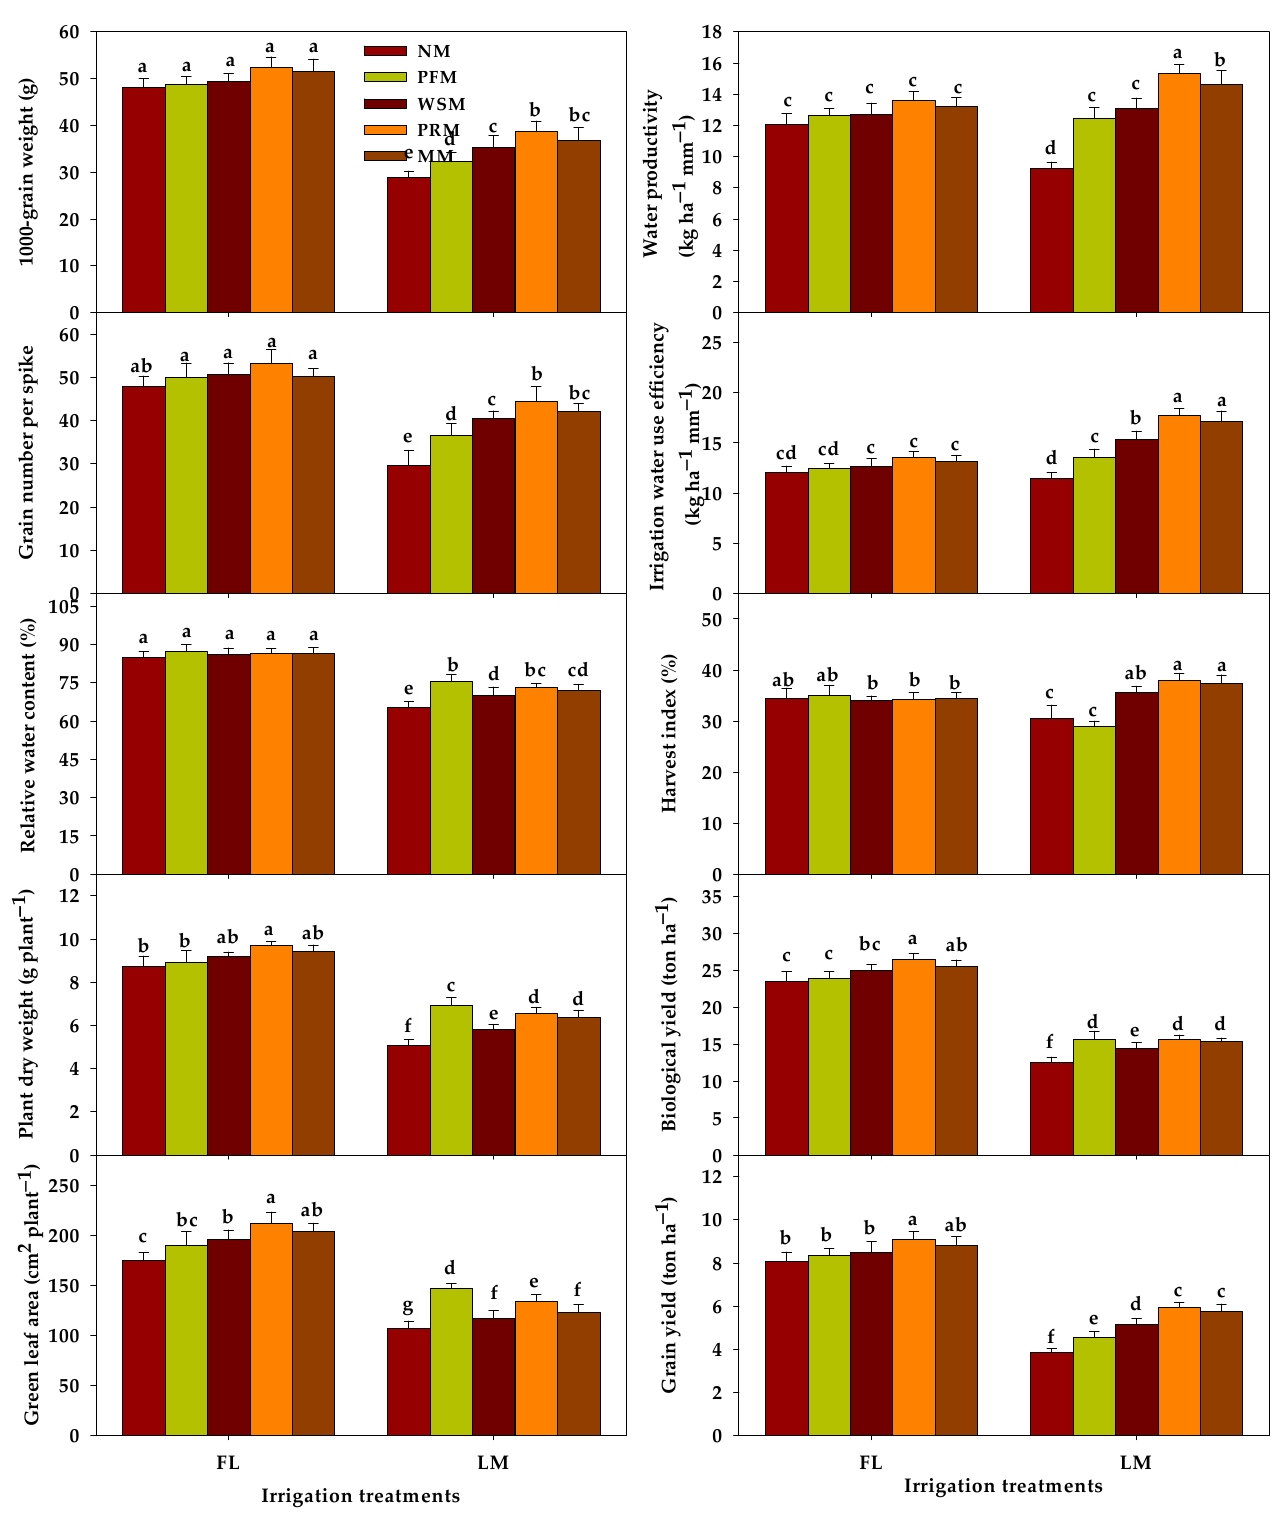
Figure 6. Response of different traits of wheat to the interaction between mulching practices and irrigation regimes in 2020 − 2021 growing season. Abbreviations in the figure indicate no mulch (NM), plastic film mulch (PFM), wheat straw mulch (WSM), palm residues mulch (PRM), and a mixture of wheat straw and palm residues at 50/50 ratio (MM), full irrigation (FL, 1.00 ET) and limited irrigation (LM, 0.50 ET) regimes. The different letters indicate statistical significance at the 0.05 level.